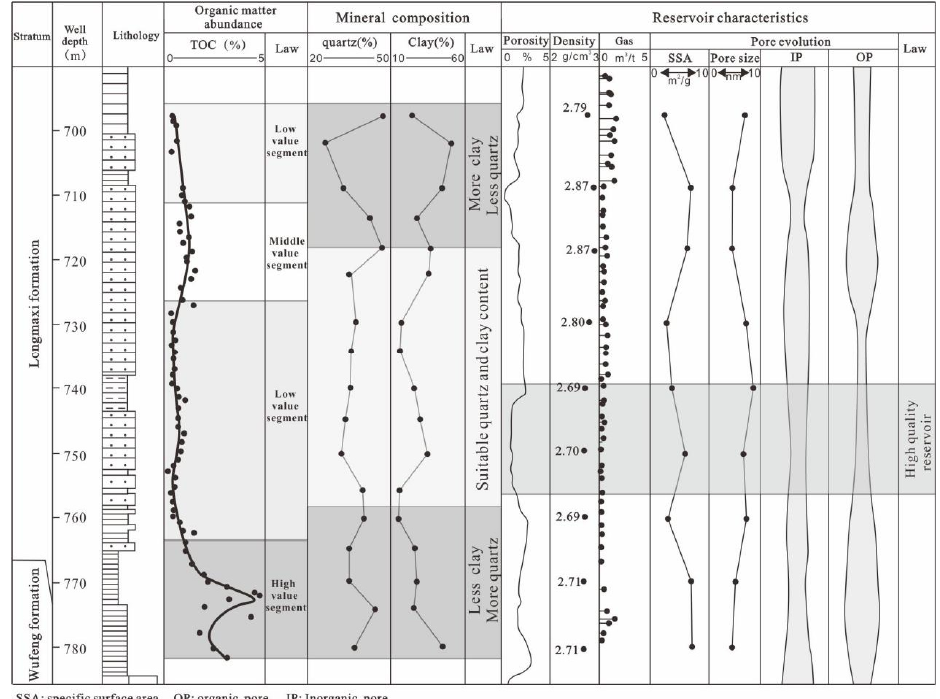
Figure 11. Coupling relationship between shale organic geochemistry and reservoir characteristics of Well Yucan-6.